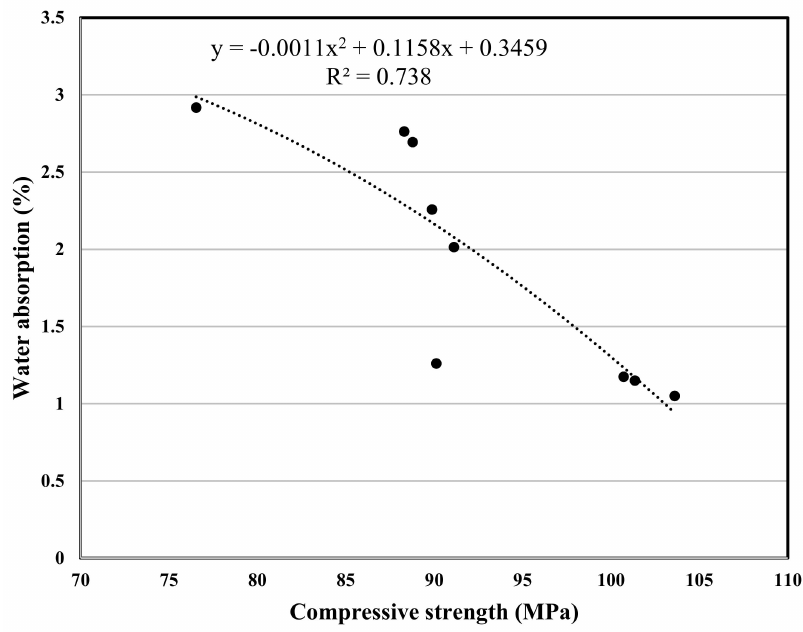
Figure 11. Correlation between compressive strength and water absorption.